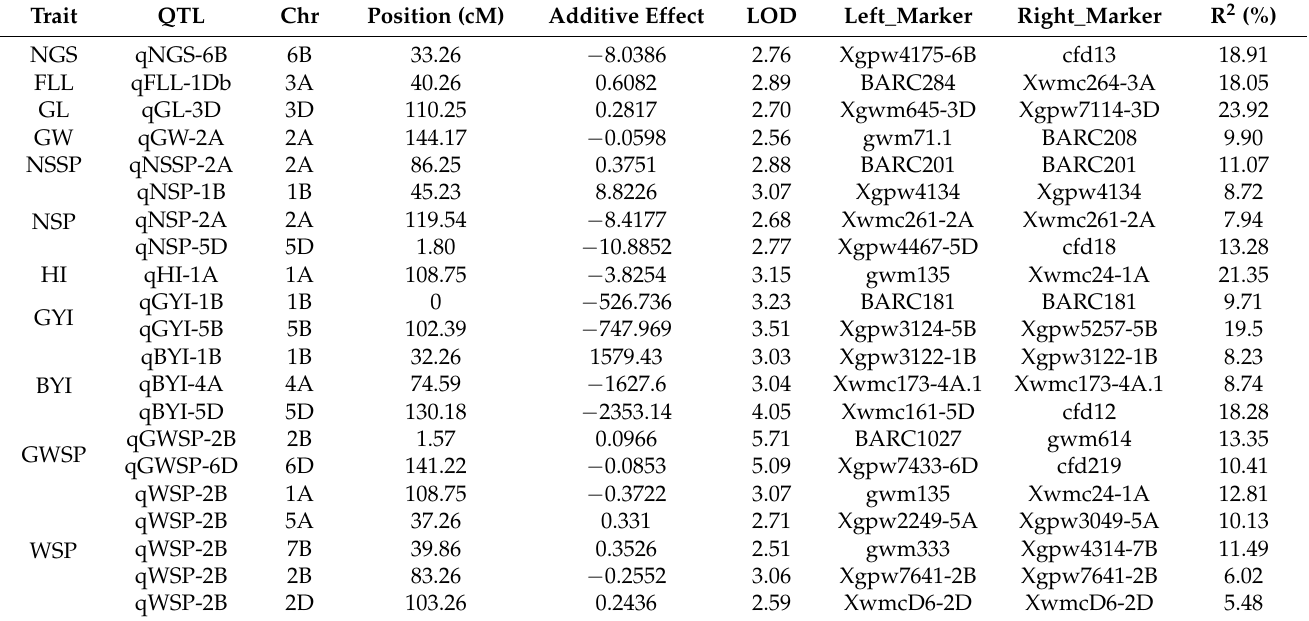
Table 7. QTLs identified using the F8 population derived from Gonbad × Kohdasht in